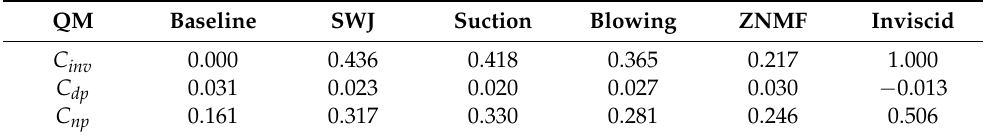
Table 3. Comparison of quality metrics (QM) for different AFC methods at C µ =